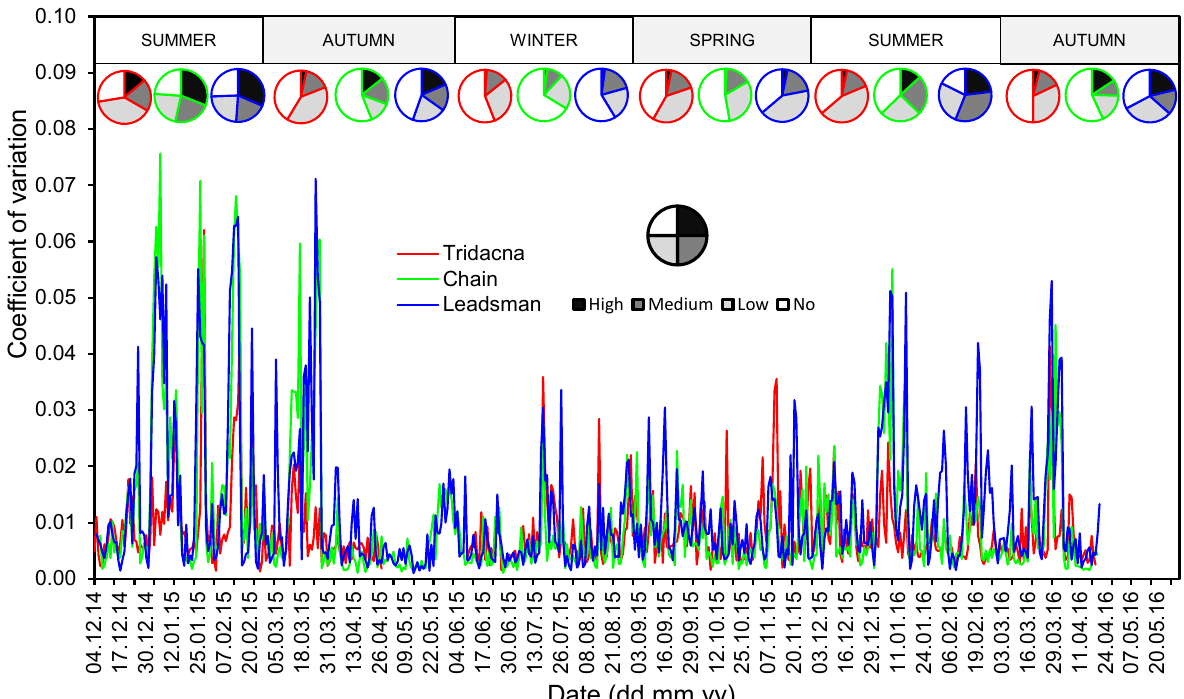
Figure 5. Temperature timeseries of daily temperature coefficients of variation (coloured lines) measured at Tridacna, Chain and Leadsman, Maputaland, South Africa as well as the relative frequencies of upwelling intensity’s (coloured pie graphs) according to each site and season leading up to peak coral bleaching surveys in April-May 2016. Colours indicate the site, whilst shading in the pie graphs indicates upwelling intensity ranging from no upwelling (white) through to high intensity upwelling (black) for each season.